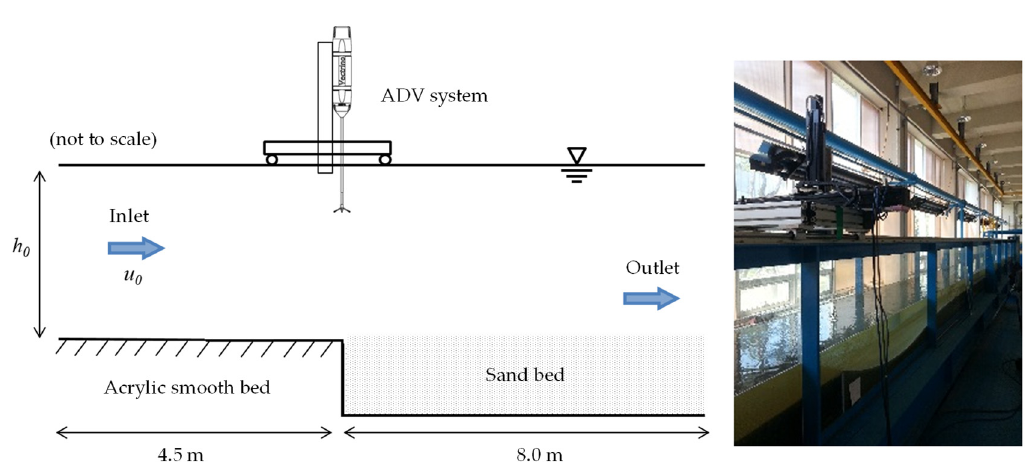
Figure 1. Laboratory experiment setup sketch ( left ) and real picture ( right ) (modified from [18]). Table 1. Physical experiment